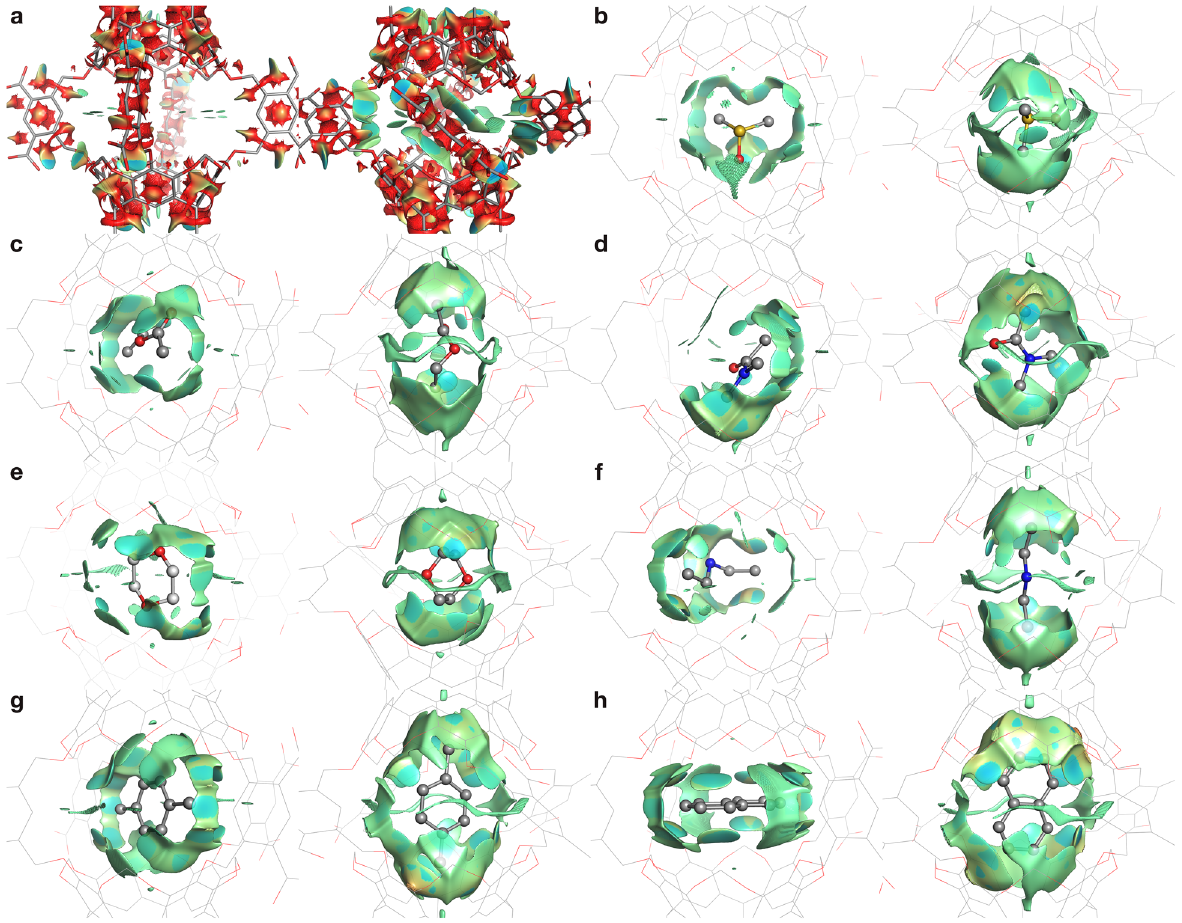
Fig. 7 Noncovalent interaction gradient isosurfaces of Octacid4 and its complexes. a Octacid4. b DMSO (cid:129) Octacid4. c EtOAc (cid:129) Octacid4. d DMA (cid:129) Octacid4. e 1,4-Dioxane (cid:129) Octacid4. f DEA (cid:129) Octacid4. g p -Xylene (cid:129) Octacid4. h Naphthalene (cid:129) Octacid4. The energy-minimized Octacid4 or its complex conformation as the initial conformation for a set of 20 MD simulations is shown on the left. The representative conformation in the largest conformation cluster of the 20 MD simulations at 298 K is shown on the right. No energy minimization was performed on these representative conformations. The sulfur, oxygen, nitrogen, and carbon atoms are in yellow, red, blue, and gray, respectively. Hydrogen atoms, counter ions, and water molecules are not displayed for clarity. The gradient isosurfaces show the intramolecular (for a ) and intermolecular (for b – h ) interactions using a blue-red scale with blue indicating strong attractions and red indicating strong